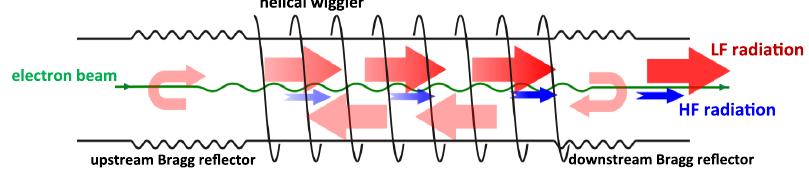
FIG. 1. Scheme of the FEM multiplier with a helical wiggler and a two-mirror Bragg resonator.